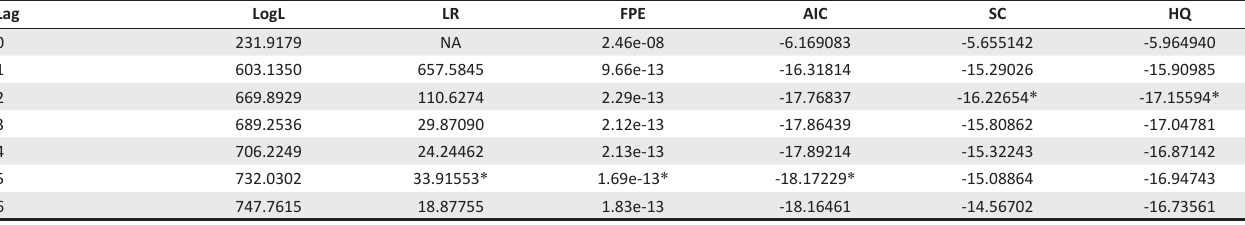
TABLE 7-A1: Lag order selection criteria.